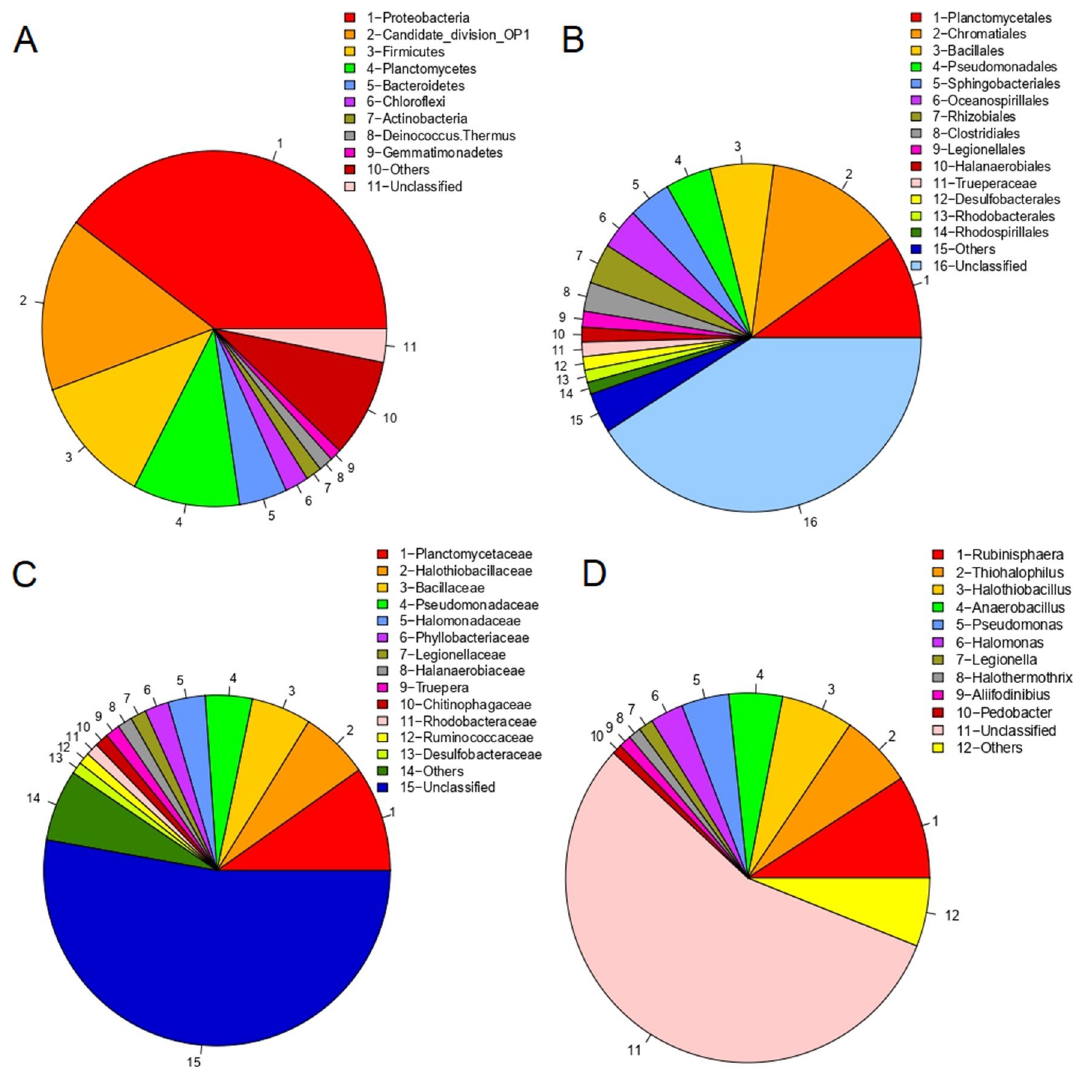
Figure 2. Pie charts of phylogenetic profiles for Bacteria Domain in Tirez sediments analyzed in 2021, at phylum ( A ), order ( B ), family ( C ) and genus ( D ) level. Taxa with a coverage lower than 1% of the total number of sequences have been grouped as “Others”. OTUs have been defined at specie level (97% similarity cutoff).